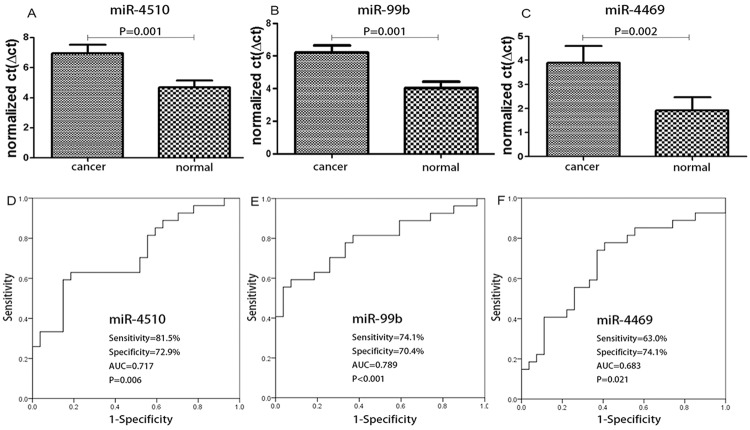
Evaluation of the potential of miR-4510, miR-99b and miR-4469 as cancer biomarkers.The results show that miR-4510, miR-99b and miR-4469 are highly likely to be diagnostic markers with high sensitivity and specificity.